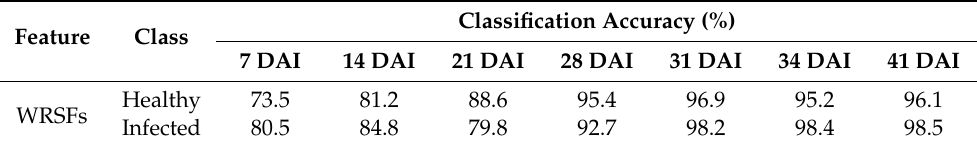
Table 8. Changes in average monitoring accuracy of yellow rust monitoring model after infestation, expressed in days after infection